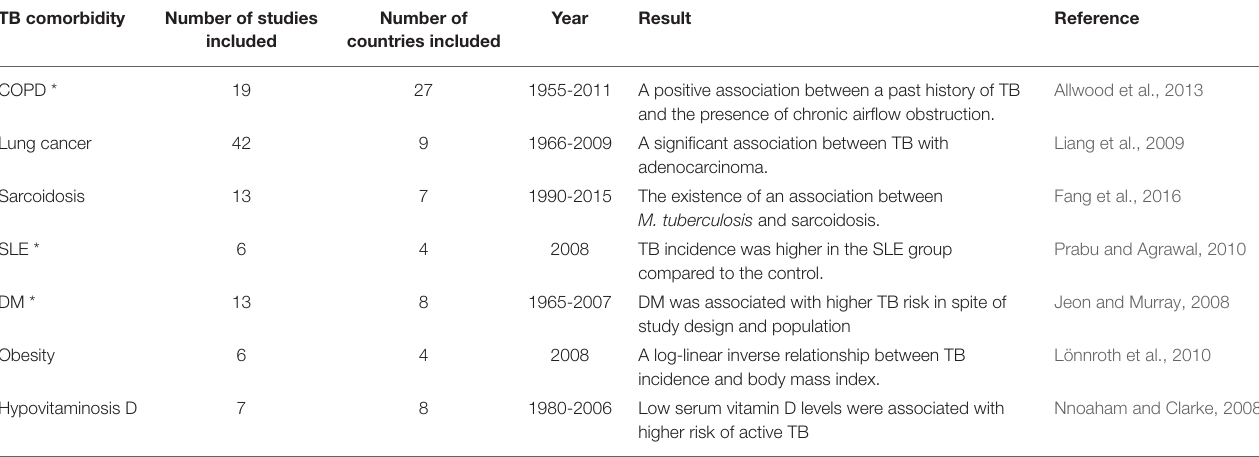
TABLE 1 | Systematic studies of the links between TB and concurrent diseases. TB